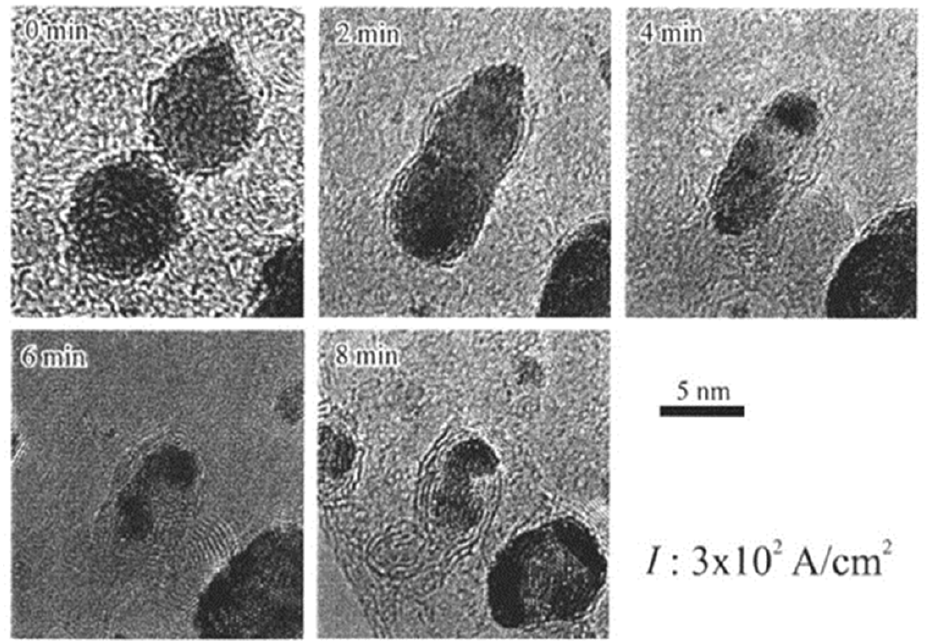
Figure 23. Effects of electron beam irradiation of W nanoparticles on an amorphous carbon film at 1.9 × 10 21 e/cm 2 s (300 A/cm 2 ). W nanoparticles migrated together and coalesced, followed by fullerene formation between the W particles and the carbon film. The general features of nanos-